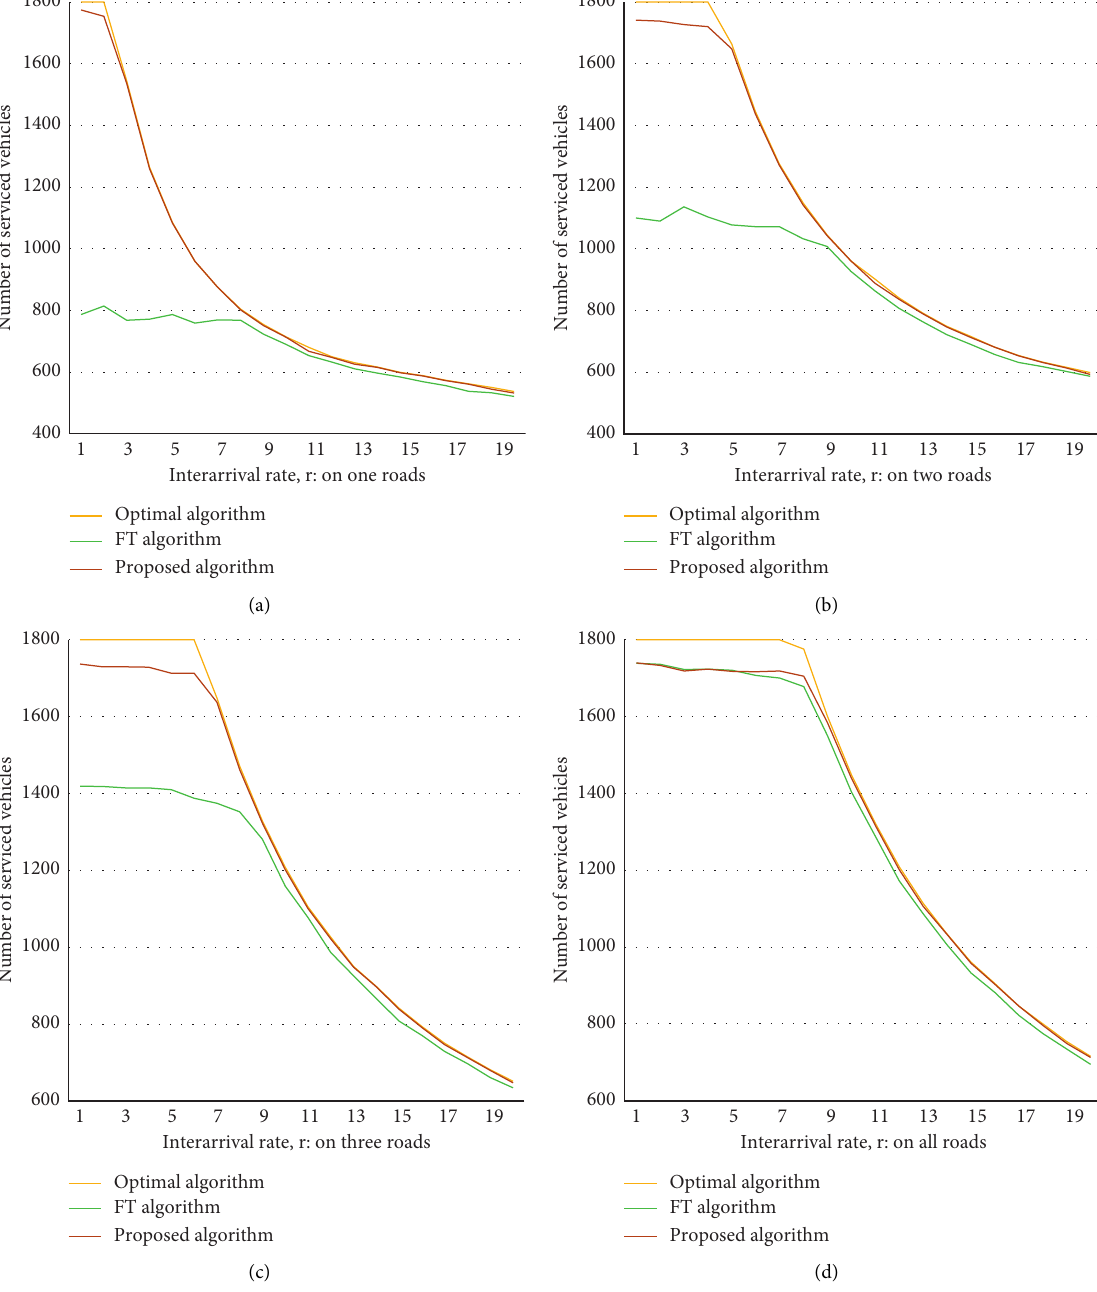
Figure 13: The number of serviced vehicles using the Optimal Algorithm (OA), the Fixed-Time (FT), and the Proposed Algorithm (PA) when the road(s) has/have varying traffic density (varying r from 1 to 20) and the other road(s) has/have constant low traffic density (constant r:30). (a) Fixing the arrival rate on three roads and varying the rate on the fourth road. (b) Fixing the arrival rate on two roads and varying the rate on the third and fourth roads equally. (c) Fixing the arrival rate on one road and varying the rate equally on the other three roads. (d) Varying the inter-arrival rate equally on all the four